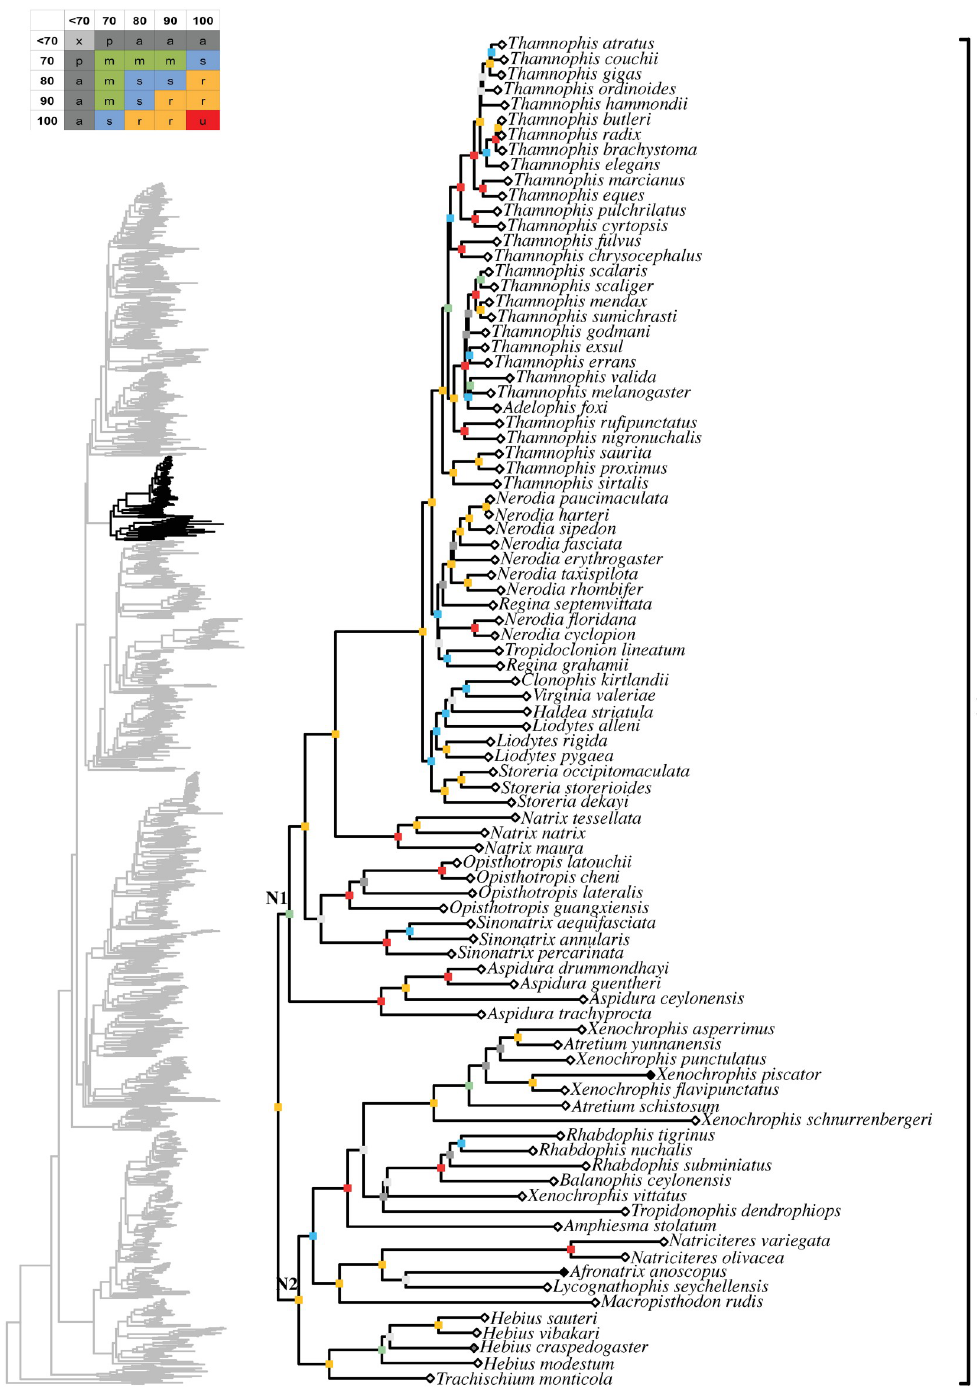
Fig 18. Maximum likelihood species-level phylogeny of Colubroides (continued). Family Natricidae.